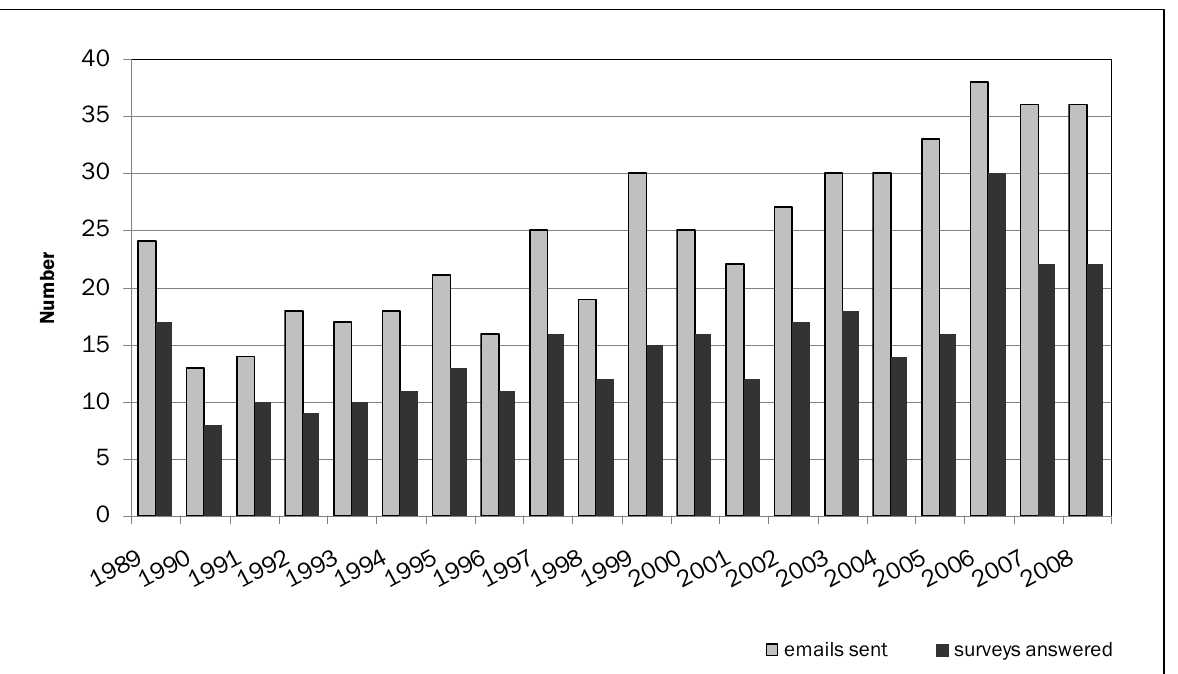
Figure 1: Number of alumni asked to participate in the study, and number of survey respondents, by graduating class